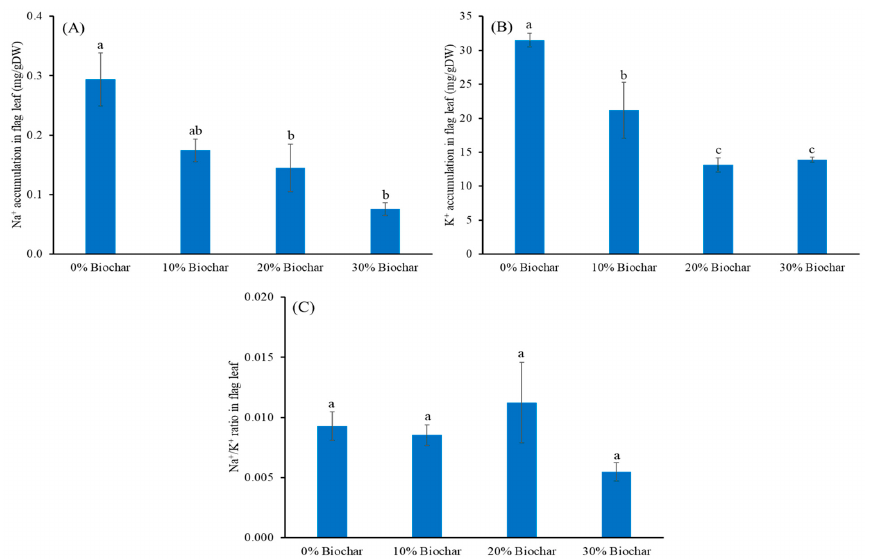
Figure 4. Na+ concentrations ( A ), K+ concentrations ( B ), and Na+/K+ ratios ( C ) for flag leaves of Phitsanulok 2 rice grown in saline soil with different rates of biochar application in Yoshida solution. Data are means ± SE (n = 3). Bars with different letters are significantly different at p < 0.05 according to DMRT.